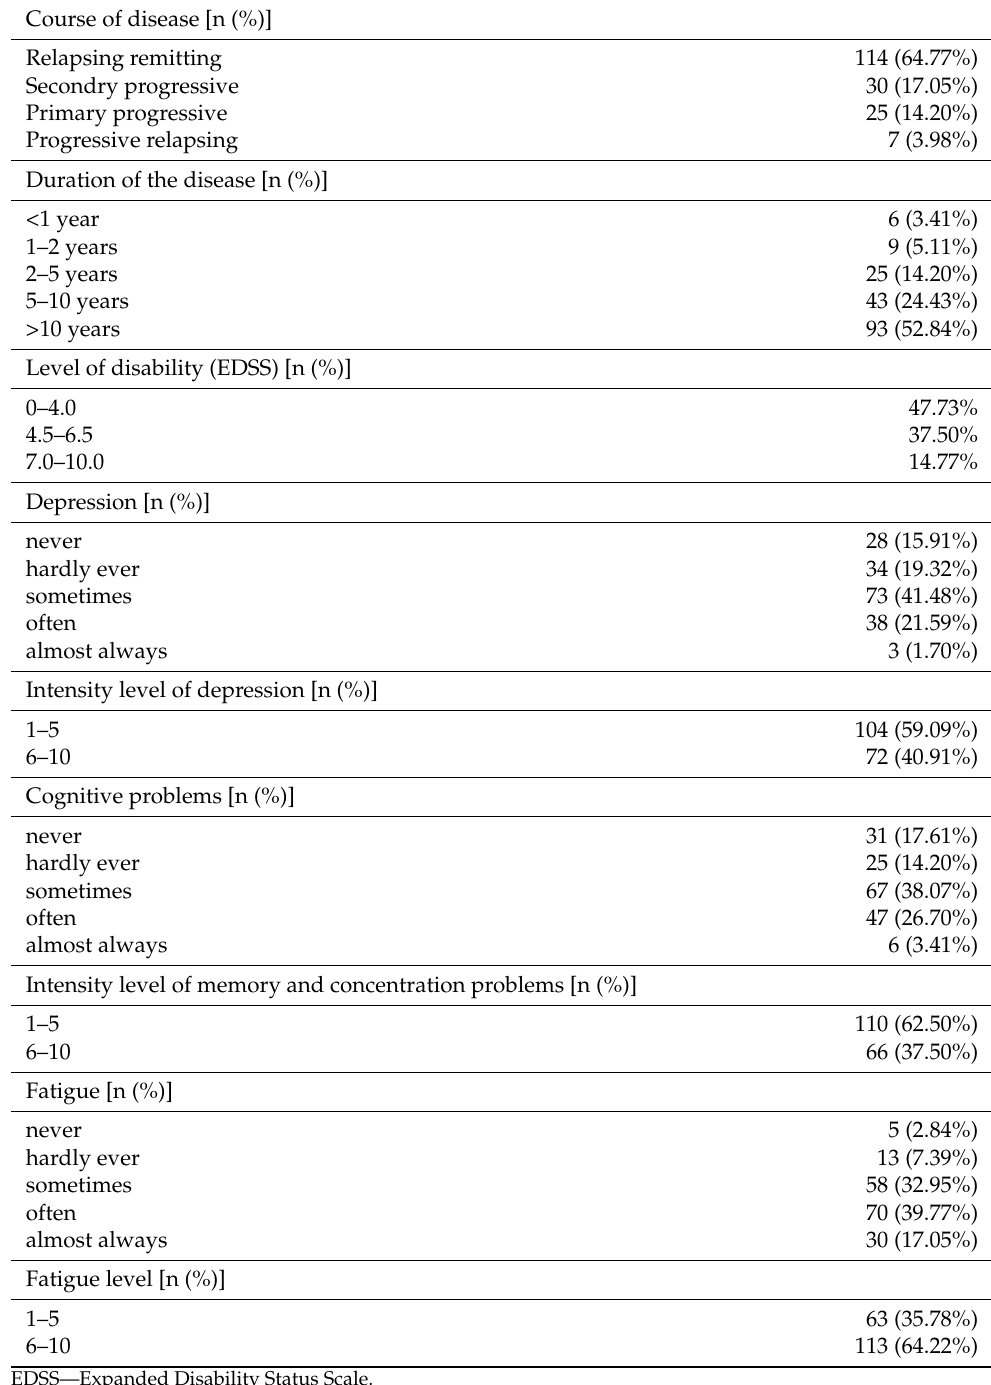
Table 2. Demographic and disease characteristics of the MS study